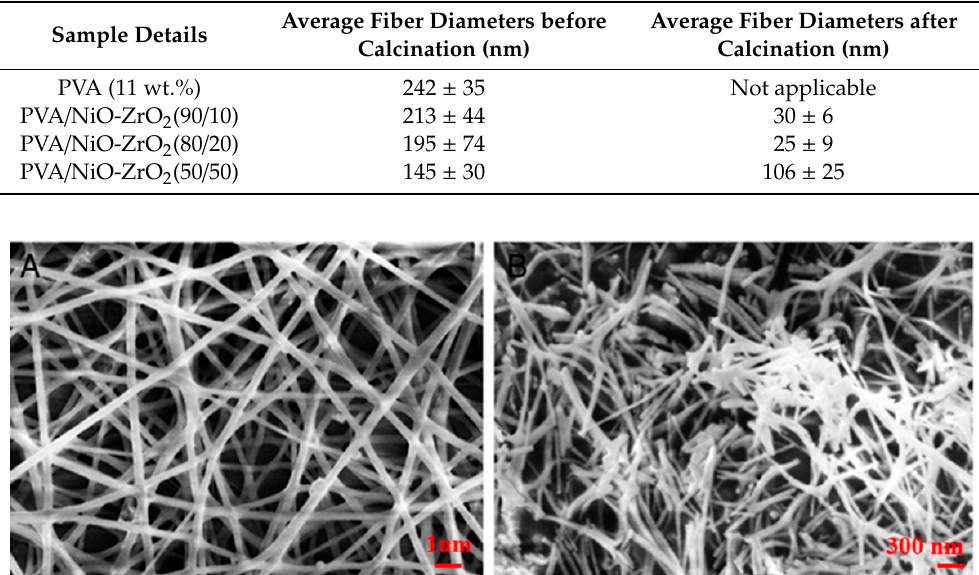
Table 2. Average fiber diameters of NiO-ZnO 2 systems before and after calcinations. Reproduced [60] with permission from Elsevier, 2014.